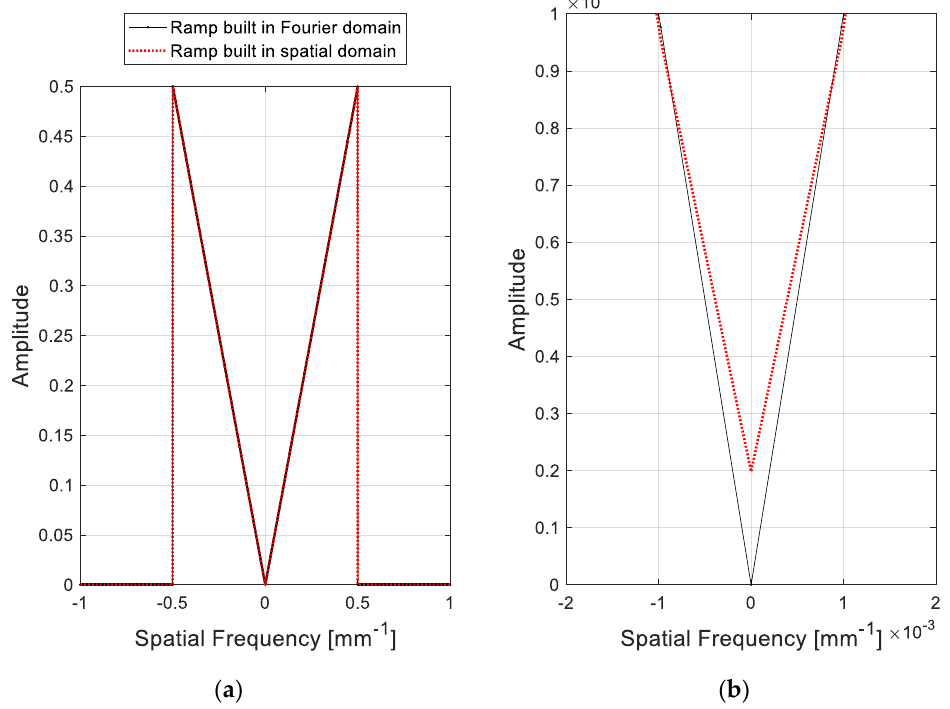
Figure 2. ( a ) Comparison of the ramp filters designed in different domains and ( b ) its magnified plot near the DC (zero frequency) component.